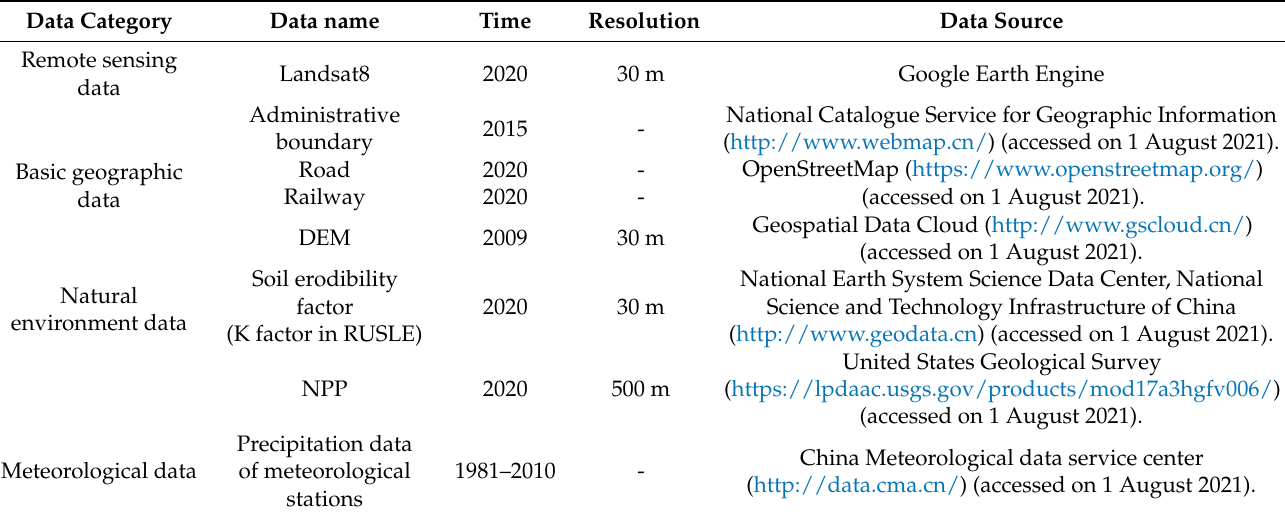
Table 1. Information of basic data.